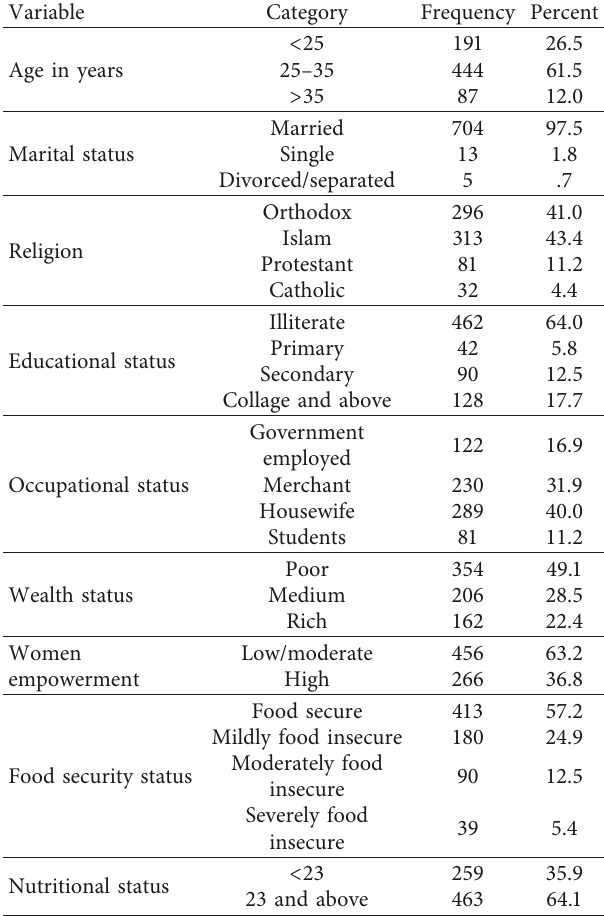
Table 1: Sociodemographic characteristics of the pregnant women, in the Gurage zone, southwest Ethiopia, September to November 2021 ( n �